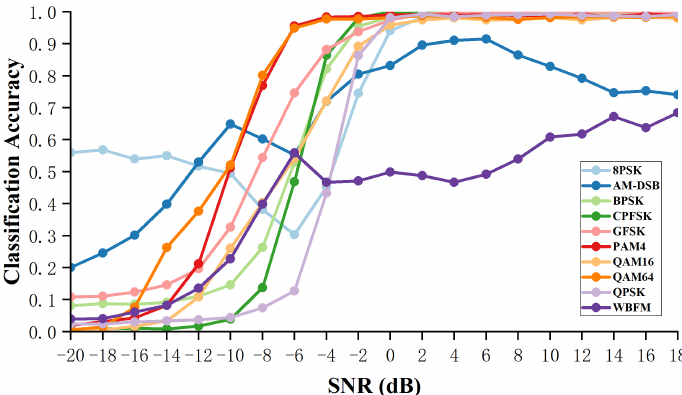
Figure 13. Classification accuracy of different kinds of modulation patterns vs.